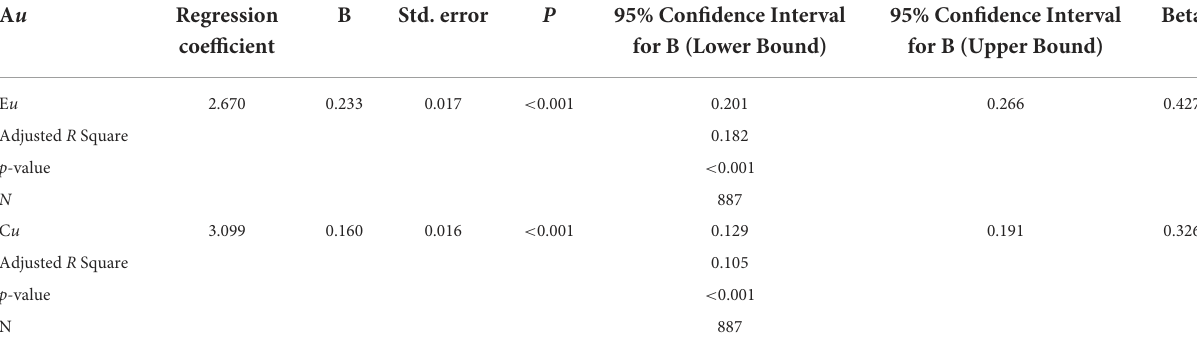
TABLE 5 Correlation and regression analysis for the self-reported comprehensive ability of undergraduate clinical medical students providing TCC.